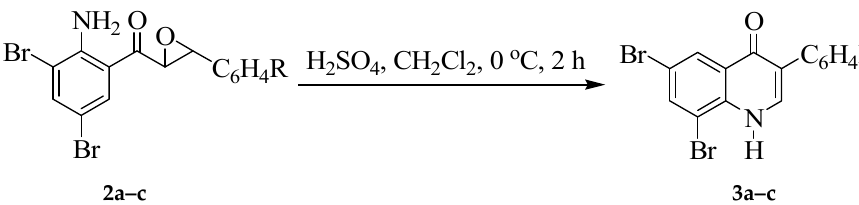
LUMO plot Figure 9. HOMO–LUMO distribution of 2a . We envisaged that the trans -2-aminochalcone epoxides 2 would undergo direct one-pot sequential acid-mediated cyclization and aryl migration of the intermediate trans -2-aryl-3-